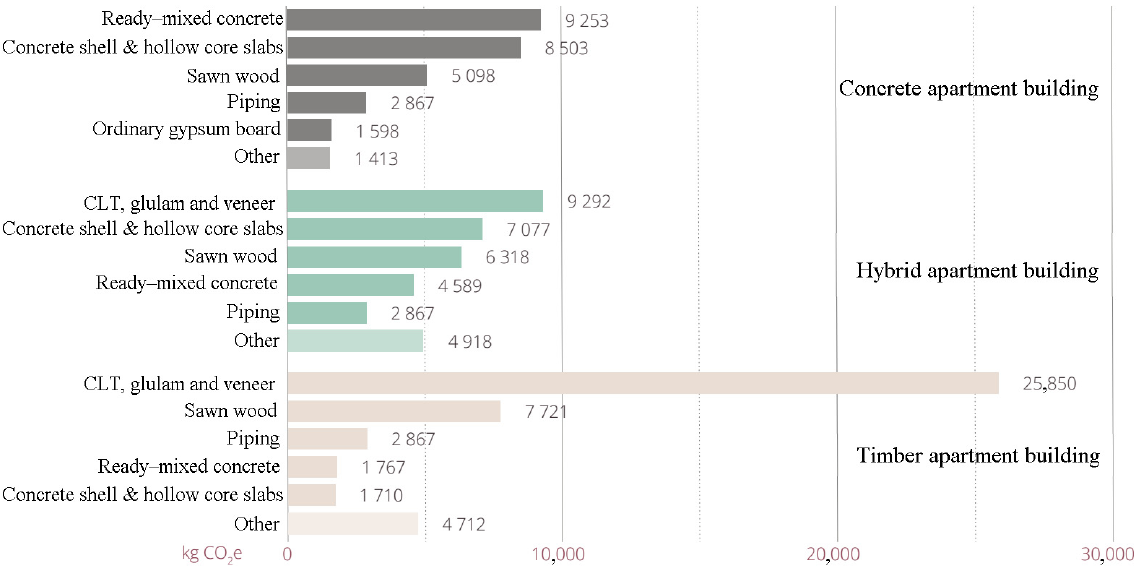
Figure 11. Distribution of carbon footprint by material in end-of-life stages C1–C4.